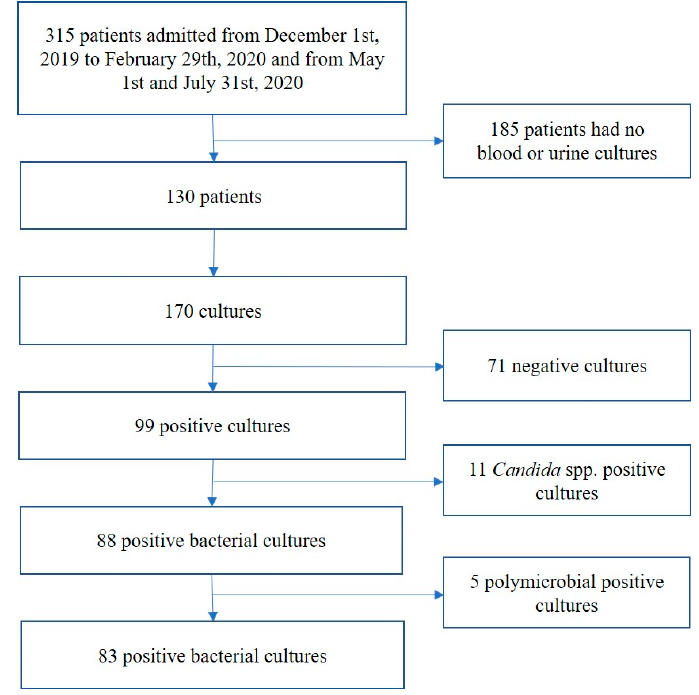
Figure 1. The flow chart of sample selection. Table 1. Patients characteristics according to the period of hospital admission (pre-COVID-19, from 1 December 2019